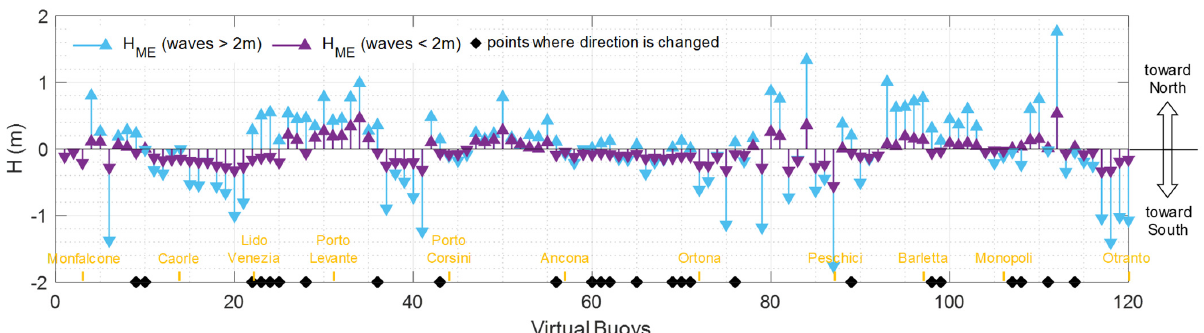
Figure 10. Magnitude of the net morphological equivalent waves H ME at the 120 virtual buoys along the Italian Adriatic coast relative to the historic run (HR). Positive arrows indicate sediment transport directed toward north; conversely, negative arrows indicate sediment transport directed toward south. Light blue arrows are the H ME computed with the waves larger than 2 m and purple arrows are the ones computed with waves smaller than 2 m.